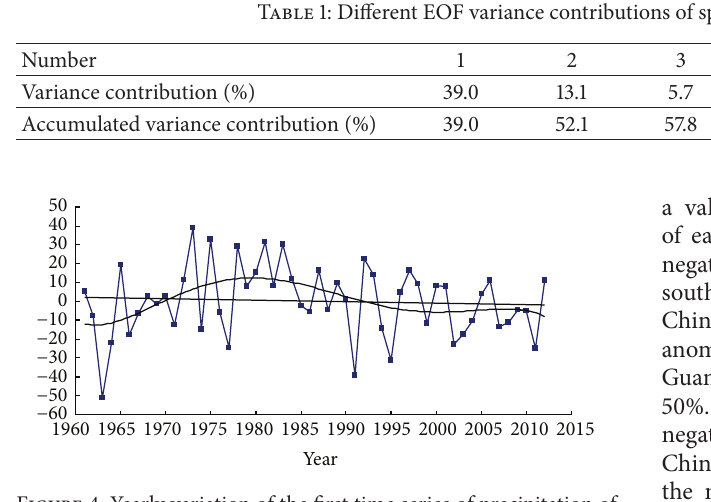
Figure 4: Yearly variation of the first time series of precipitation of South China spring precipitation.